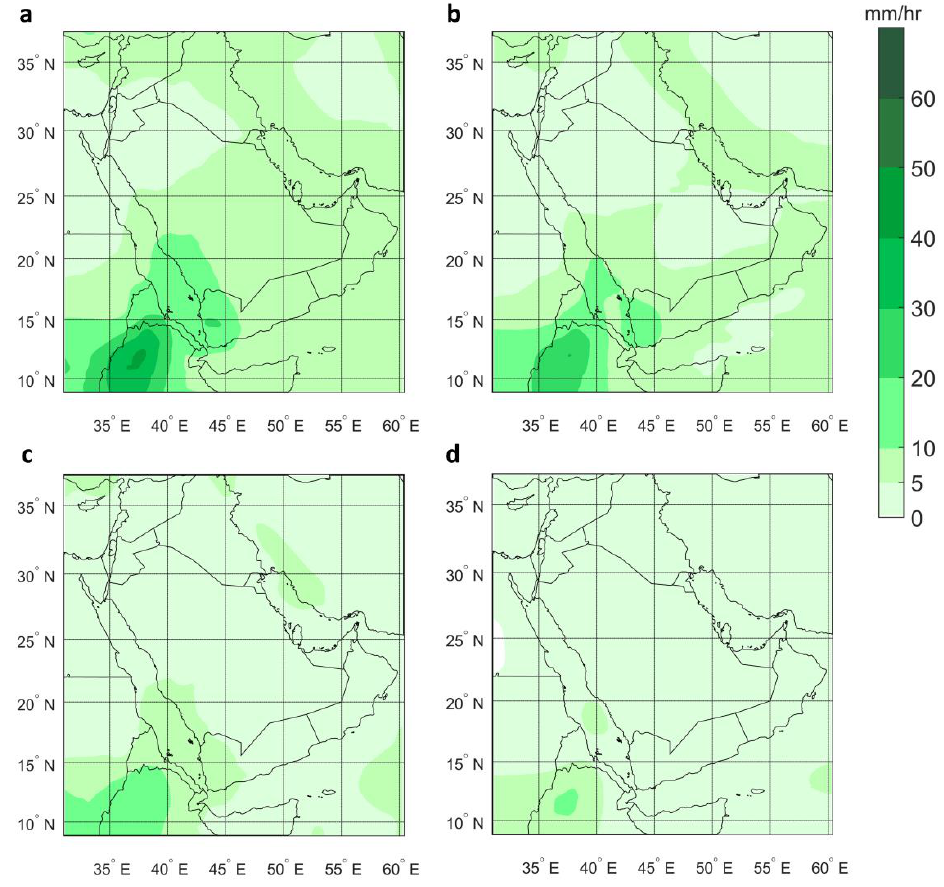
Figure 14. Average rainfall intensity (modeled) for durations of 3, 6, 12 and 24 hours ( a – d , respec- tively) and a 25-year return period.